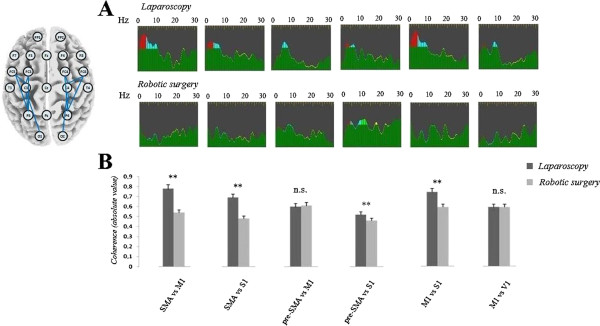
Intra-hemispheric coherence changes between laparoscopic and robotic modality. Sample of intra-hemispheric coherence changes in the same surgeon operating with a laparoscopic (top traces) or a robotic (bottom traces) approach is shown in top panel (A). The colors represent the four frequency bands analyzed (red: delta; blue: theta; green: alpha 1 and alpha 2; yellow: beta) and were marked when the absolute value of the coherence function was > 0.5. Note the higher functional coupling, especially at theta band, in surgeons using a laparoscopic approach. The bottom panel (B) shows the mean absolute value of coherence function in theta and lower alpha band for all the comparisons analyzed; surgeons operating with a conventional laparoscopic procedure show significant higher values, except for the comparisons pre-SMA vs. M1 and M1 vs. V1 (**p < 0.001; *p < 0.01; n.s.: not significant). Inset on the upper left side represents an exemplificative pattern of intra-hemispheric channel comparisons.